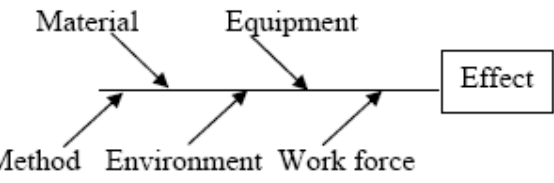
Figure 2: Schematic representation of Ishikawa’s